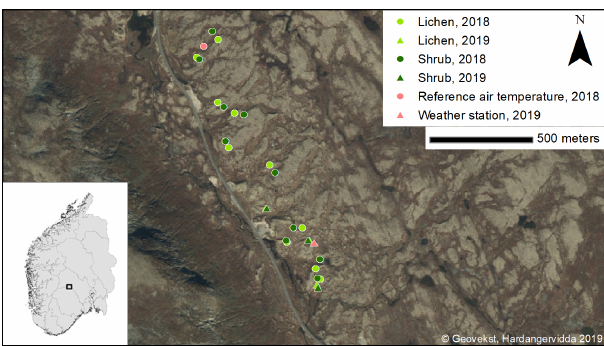
Figure 1. Locations of the plots in the study area. Inset: location of Imingfjellet in southern